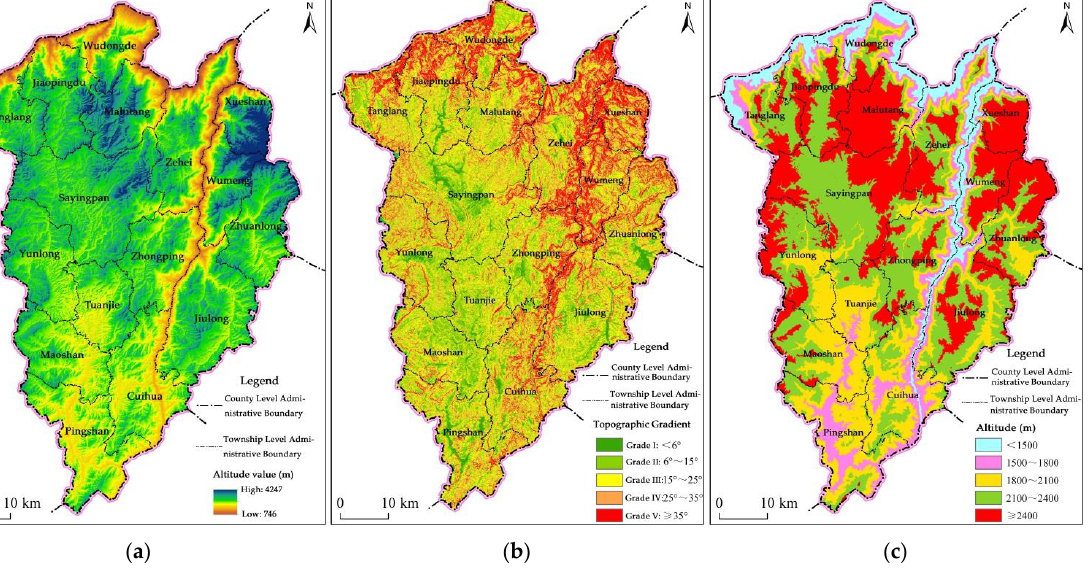
Figure 2. Results of topographic gradient and elevation classification in Luquan County. ( a ) The altitude map of Luquan County; ( b ) the topographic gradient grading map of Luquan County; ( c ) the elevation grading map of Luquan County.